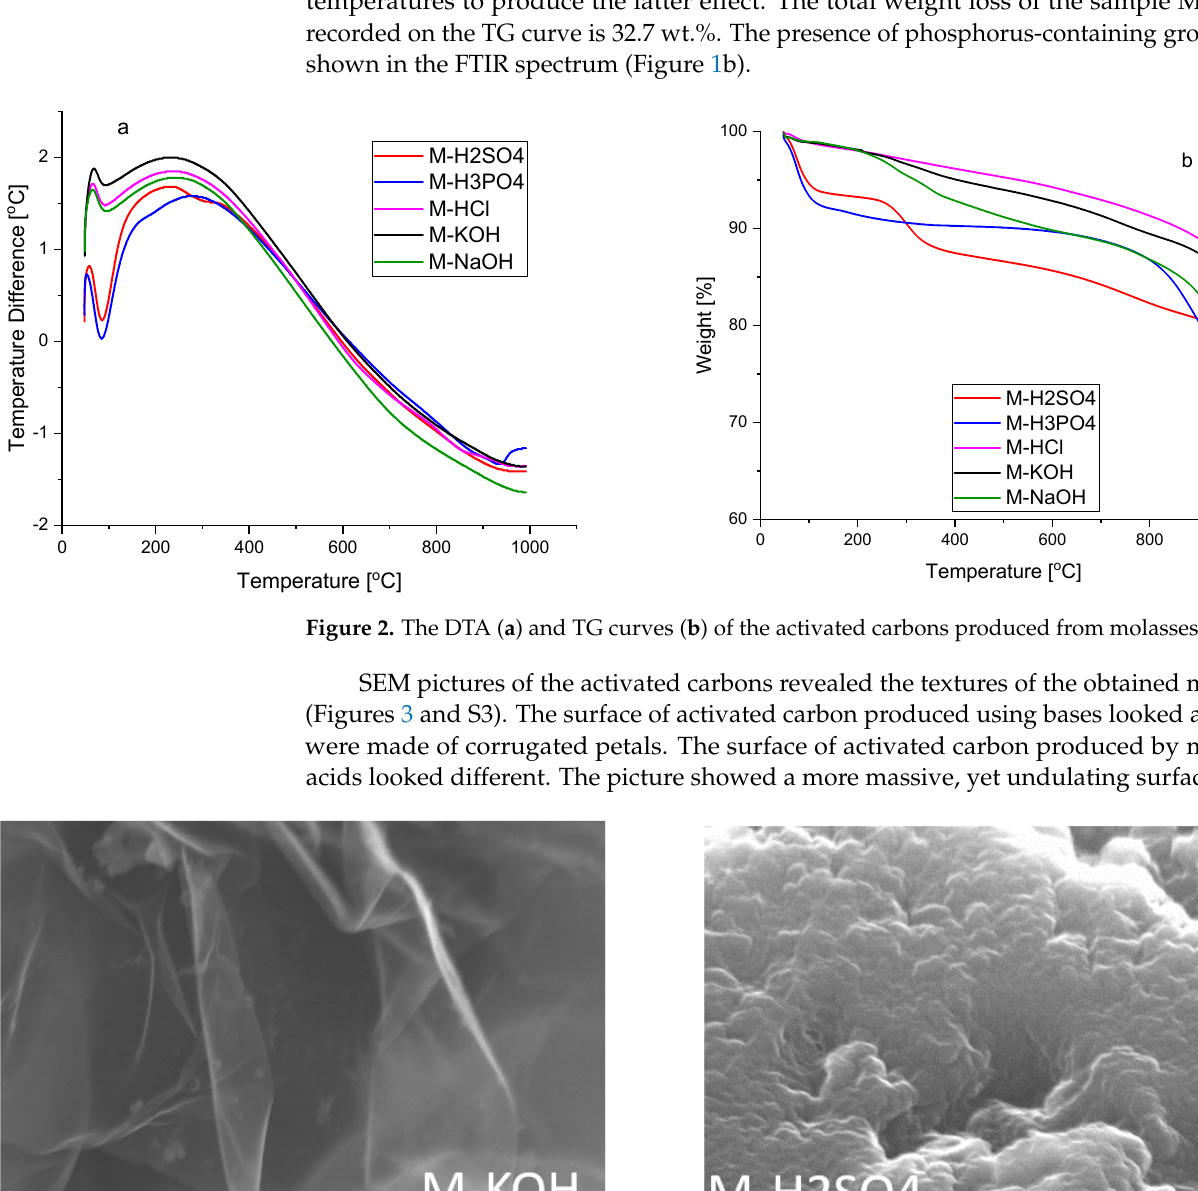
Figure 4. Adsorption–desorption isotherms of nitrogen ( a ) and micropore pore size distribution cal- culated by the DFT method ( b ) for activated carbons from molasses. According to the IUPAC classification, the three nitrogen adsorption isotherms pre- sented in Figure 4a, except M-KOH and M-HCl, represent a composite of Types Ia and IV. The isotherm of activated carbon M-KOH was Type Ib. The ideal Ia and Ib isotherms are characterized by the relatively quick achievement of the adsorption limit, which results in the course of the adsorption isotherm being parallel to the P/P 0 axis. The isotherms pre- sented in Figure 4a were parallel to the P/P 0 axis in most ranges of P/P 0 . Detailed studies on macropores have not been carried out due to the fact that these pores are not crucial 0.0